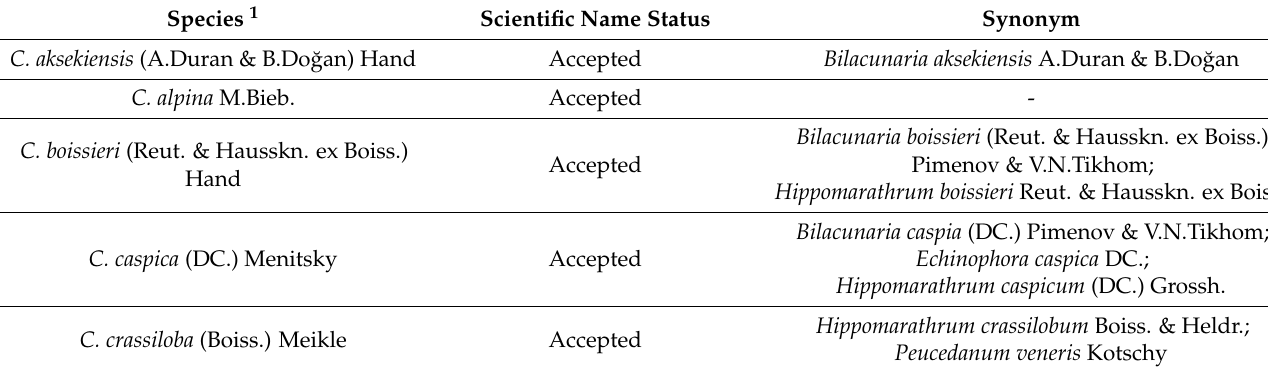
Table 1. Cachrys L. genus: included